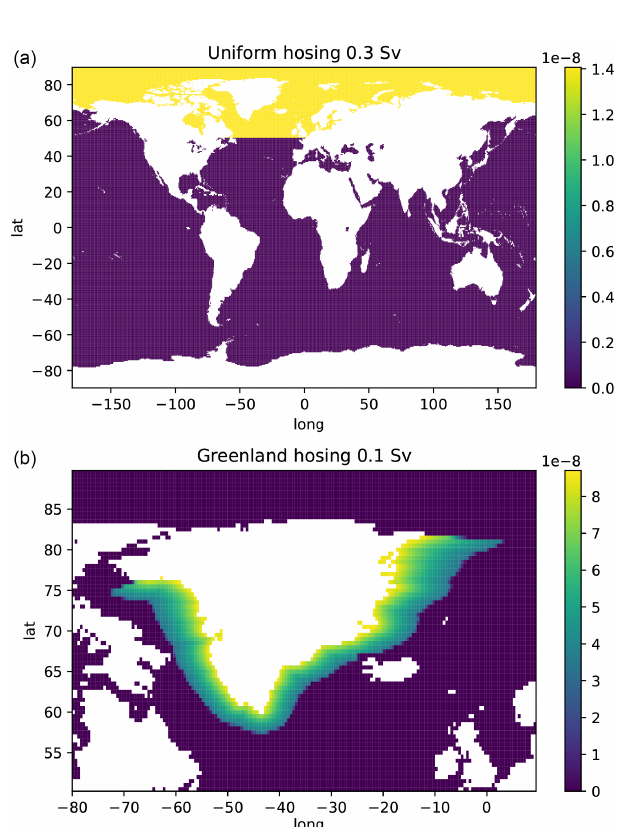
Figure 1. Hosing fields: (a) shows the hosing field used for u03-hos, and (b) shows the hosing field used for g01-hos. Units are ms − 1